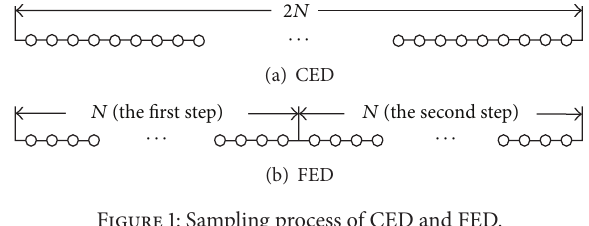
Figure 1: Sampling process of CED and